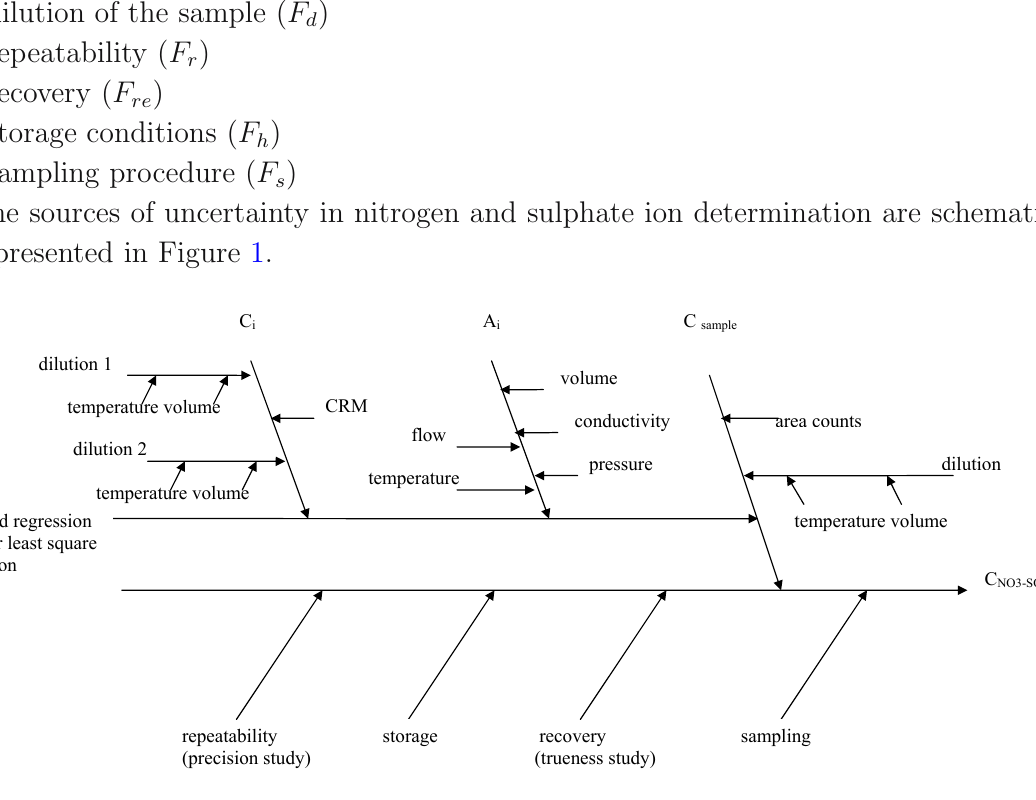
Fig. 1 Cause and effects diagram for the determination of nitrate and sulphate, using the ion chromatography